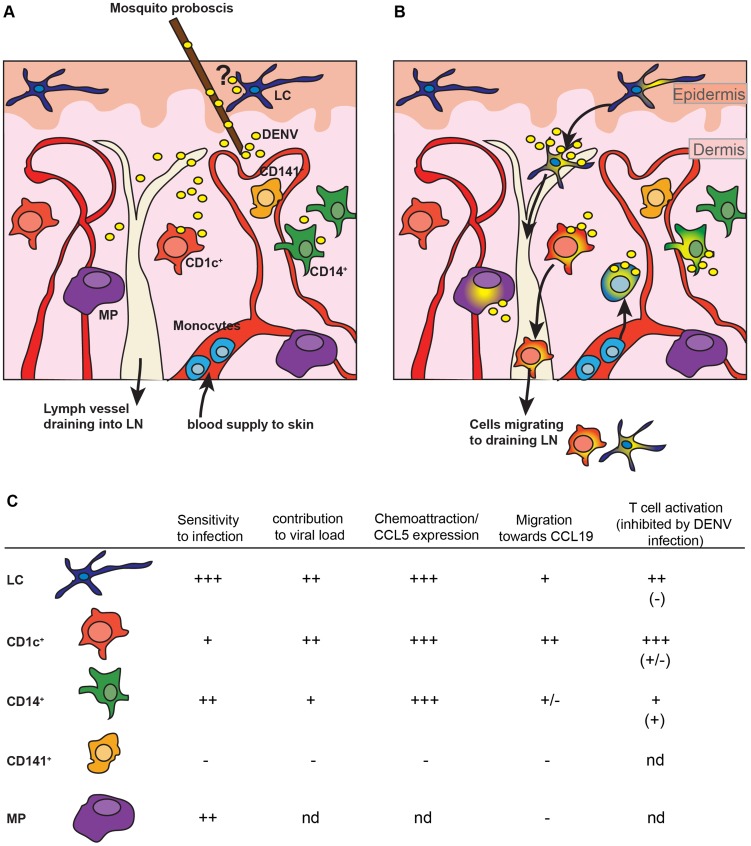
Model for skin dengue infection.(A) The mosquito searches for blood vessels in the dermis and thereby releases saliva that contains virus. The proboscis bypasses the epidermis. The question mark indicates that it is not clear whether during the process of probing virus is also released into the epidermis. (B) Virus in the dermis infects CD1c+ and CD14+ dermal DCs and macrophages (MP), but not CD141+ DCs. Infected CD1c+ DCs and possibly LCs migrate to draining LNs to initiate the adaptive immune response. Based on their non-migratory behavior ex vivo (Fig. 3E and [12]) CD14+ DCs are not expected to migrate to draining LNs. Based on mouse studies, monocyte-derived cells that infiltrate into the skin are infected efficiently (Fig. 6) and contribute to the local and systemic immune response. (C) Table summarizing the role of skin APCs during infection with DENV using single cell suspensions.